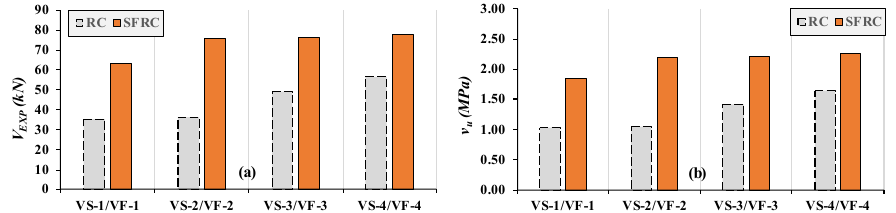
Figure 6. (a) Shear strength and (b) Shear stress.